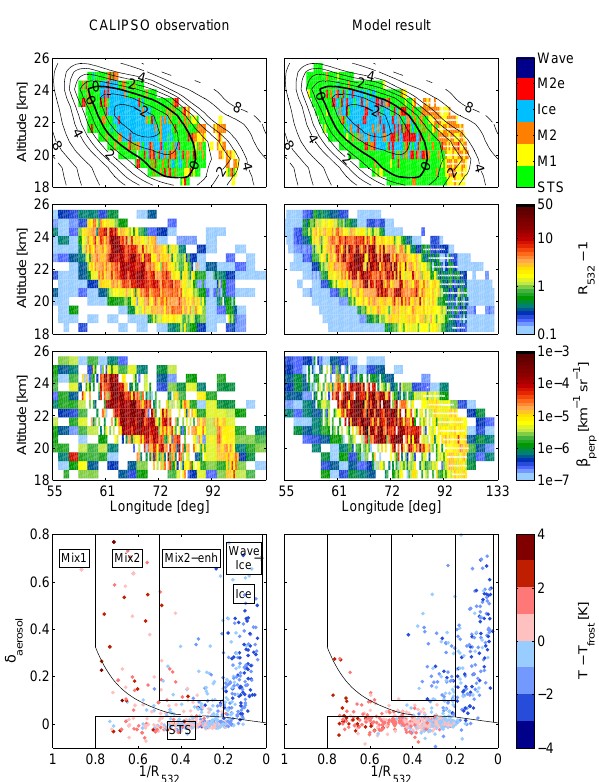
Fig. 10. 26 February 2011: CALIPSO orbit track 2011-02-26T23- 09-10Z. CALIOP measurements are shown in the left column, model results in the right column. White striped areas indicate tra- jectories with temperatures below T NAT − 4K longer than 80h or temperatures below T NAT at the trajectory’s starting point. Contour lines and the color-coded data presented in the lowermost row dis- play ERA-Interim temperatures relative to T frost